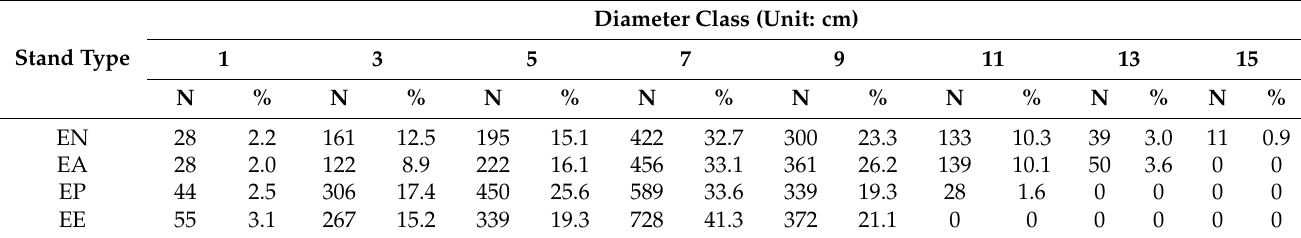
Table 5. Diameter class distribution of pure Eucalyptus forest and mixed- Eucalyptus